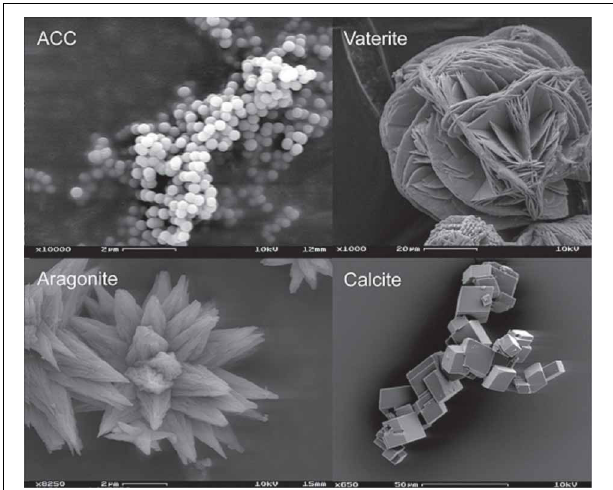
FIGURE 3 | Polymorphs of CaCO